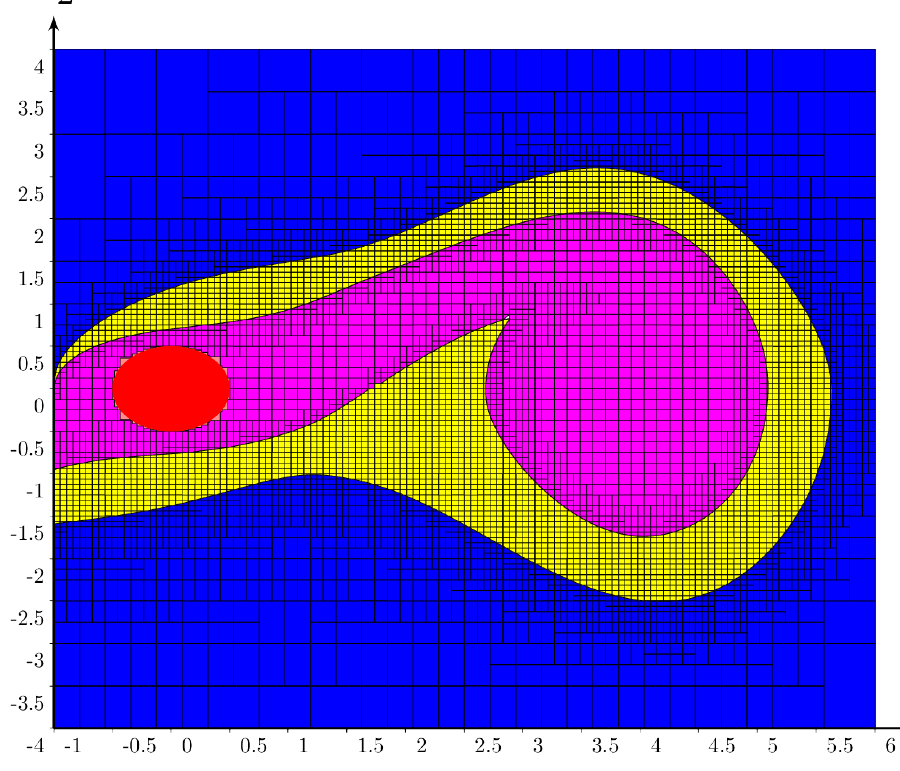
Figure 11. Inner and outer approximation of the control forward reach